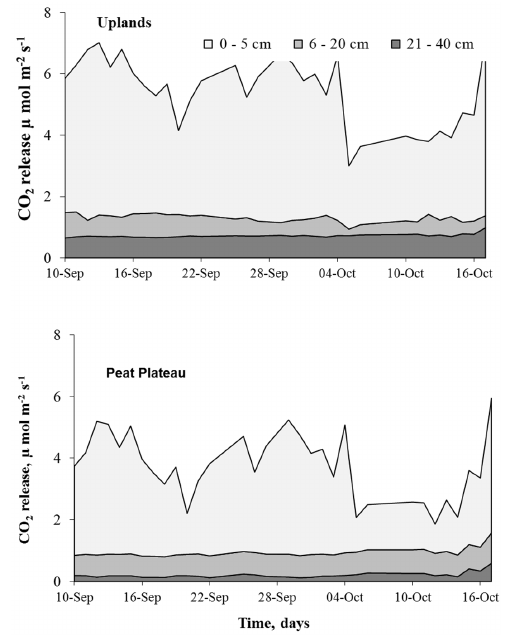
Figure 7. Comparative contribution of different soil layers to soil CO 2 efflux in uplands (top panel) and peat plateau (bottom panel) during 2008 at Fort Simpson (NWT) Canada.